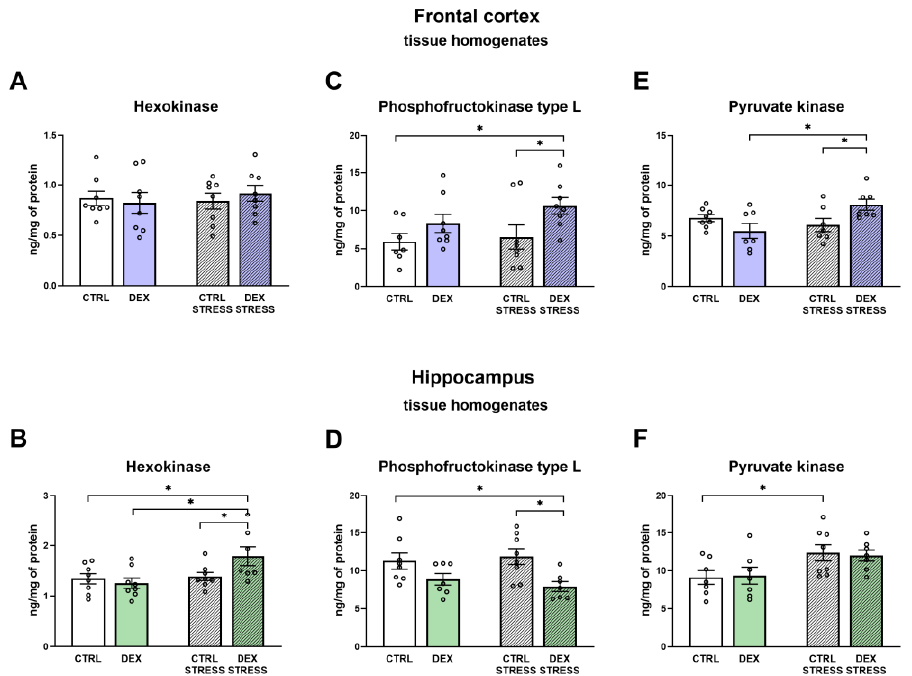
Figure 4. The effects of DEX treatment and acute stress on the levels of enzymes hexokinase, phos- phofructokinase, and pyruvate kinase in tissue homogenates of the frontal cortex ( A , C , E ) and the hippocampus ( B , D , F ); enzyme levels were determined with ELISA assays; * p < 0.05, n = 7–8. The results are expressed as the mean ± SEM. Statistics: two-way ANOVA, followed by the Duncan test.